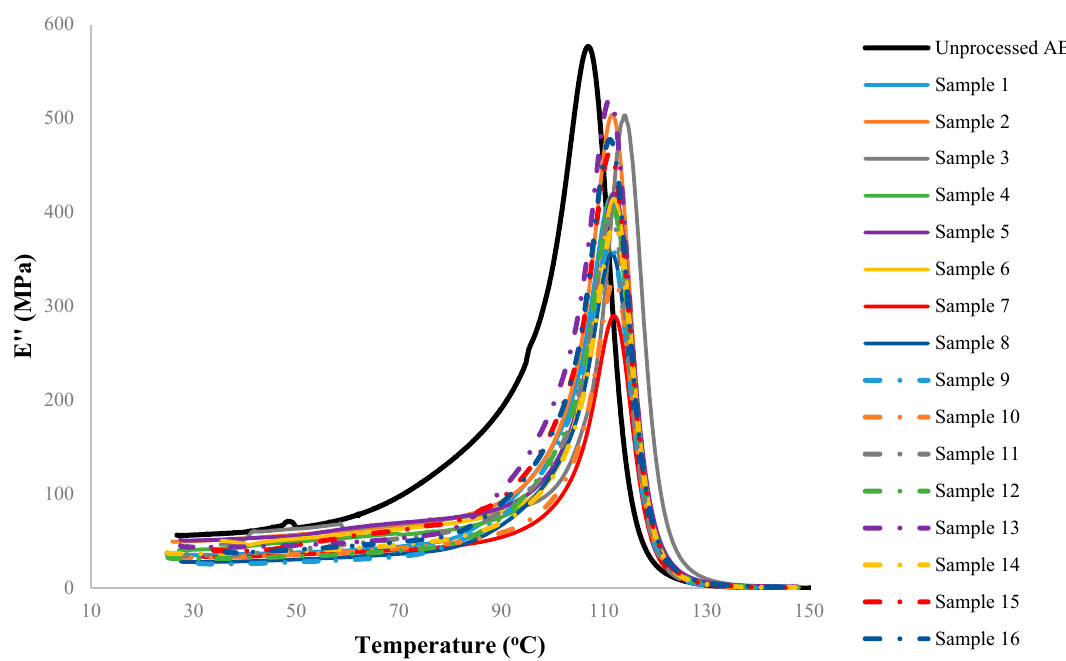
Figure 5. The variation of the loss modulus versus temperature for the test specimens.